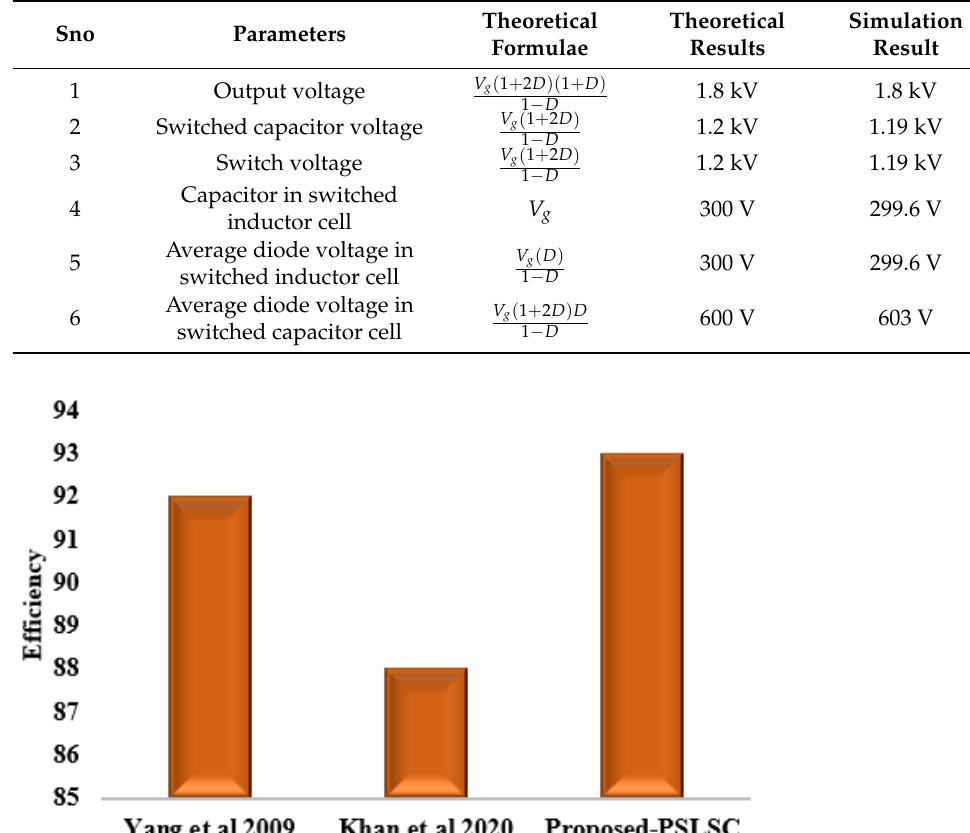
Table 7. Comparison of simulation and theoretical results.